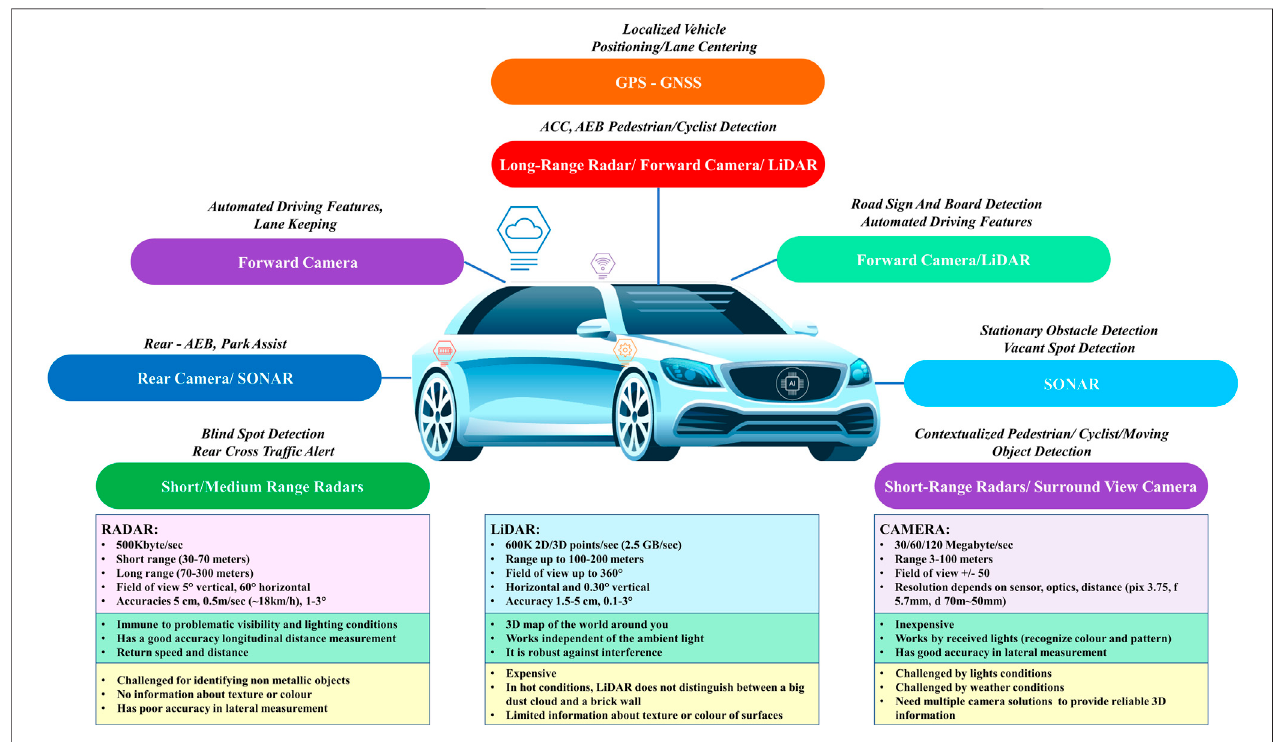
FIGURE 6 | ECAS vehicle perception